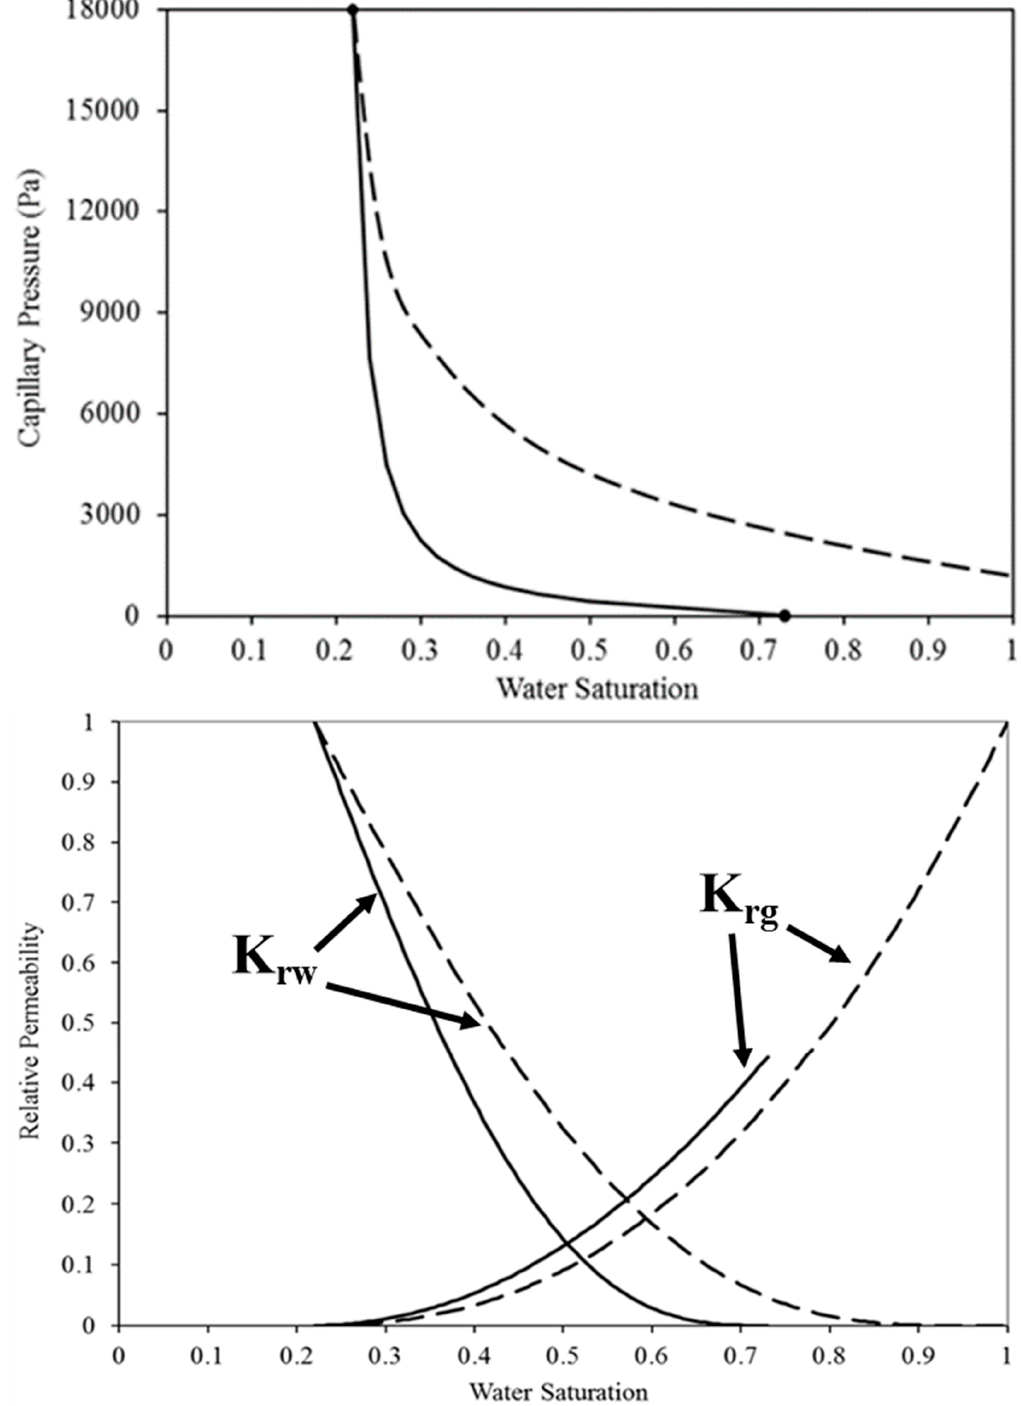
Figure 2. The imported Pc ( top ) and relative permeability ( bottom ) curves for the sandstone rocks. Dashed lines represent the CO 2 injection process and solid lines represent the post-injection process.